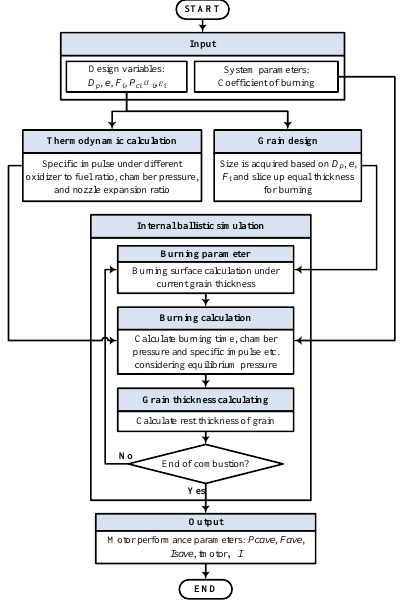
Figure 3. The steps involved in general design procedure of HRMs.